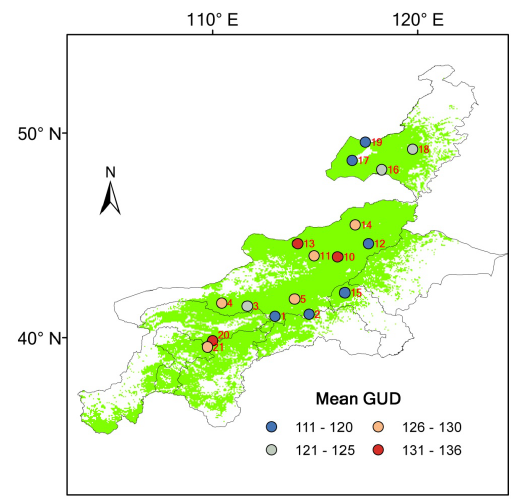
Fig. 6. The spatial pattern of 25-year averaged Green-up Onset Date (GUD) of the stations.